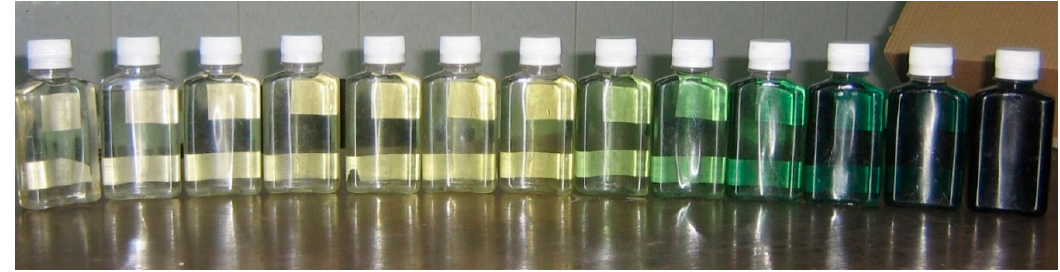
Figure A1. The solution colour changes in the course of molybdenite flue dust leaching. It first became pale yellow ( right ), then turned into green, and finally dark blue ( left ).